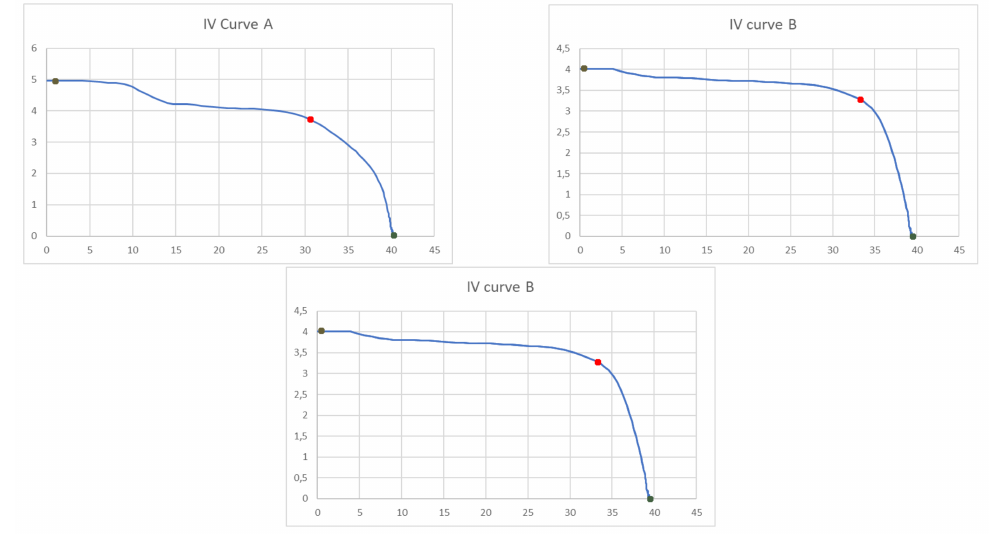
Figure 2. Different IV curves. Green circle: Max Power Point; Red Star: Open-Circuit Voltage ( V OC ); Yellow Square: Short-Circuit Current ( I SC